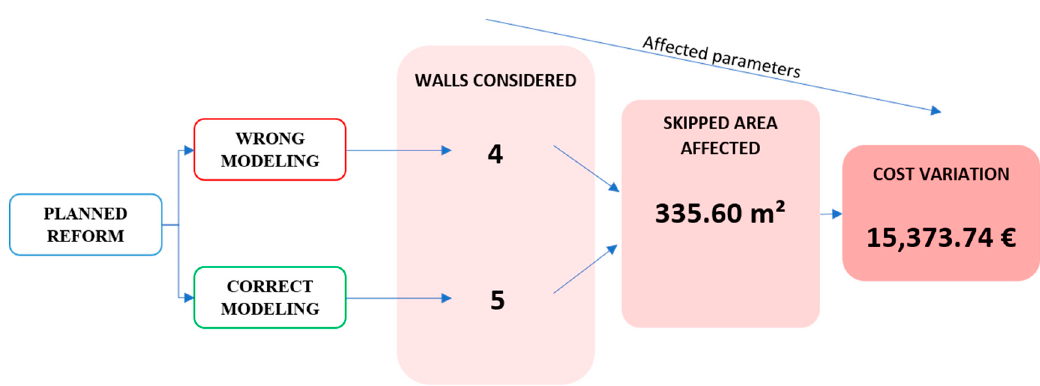
Figure 6. Parameters variations by modeling.